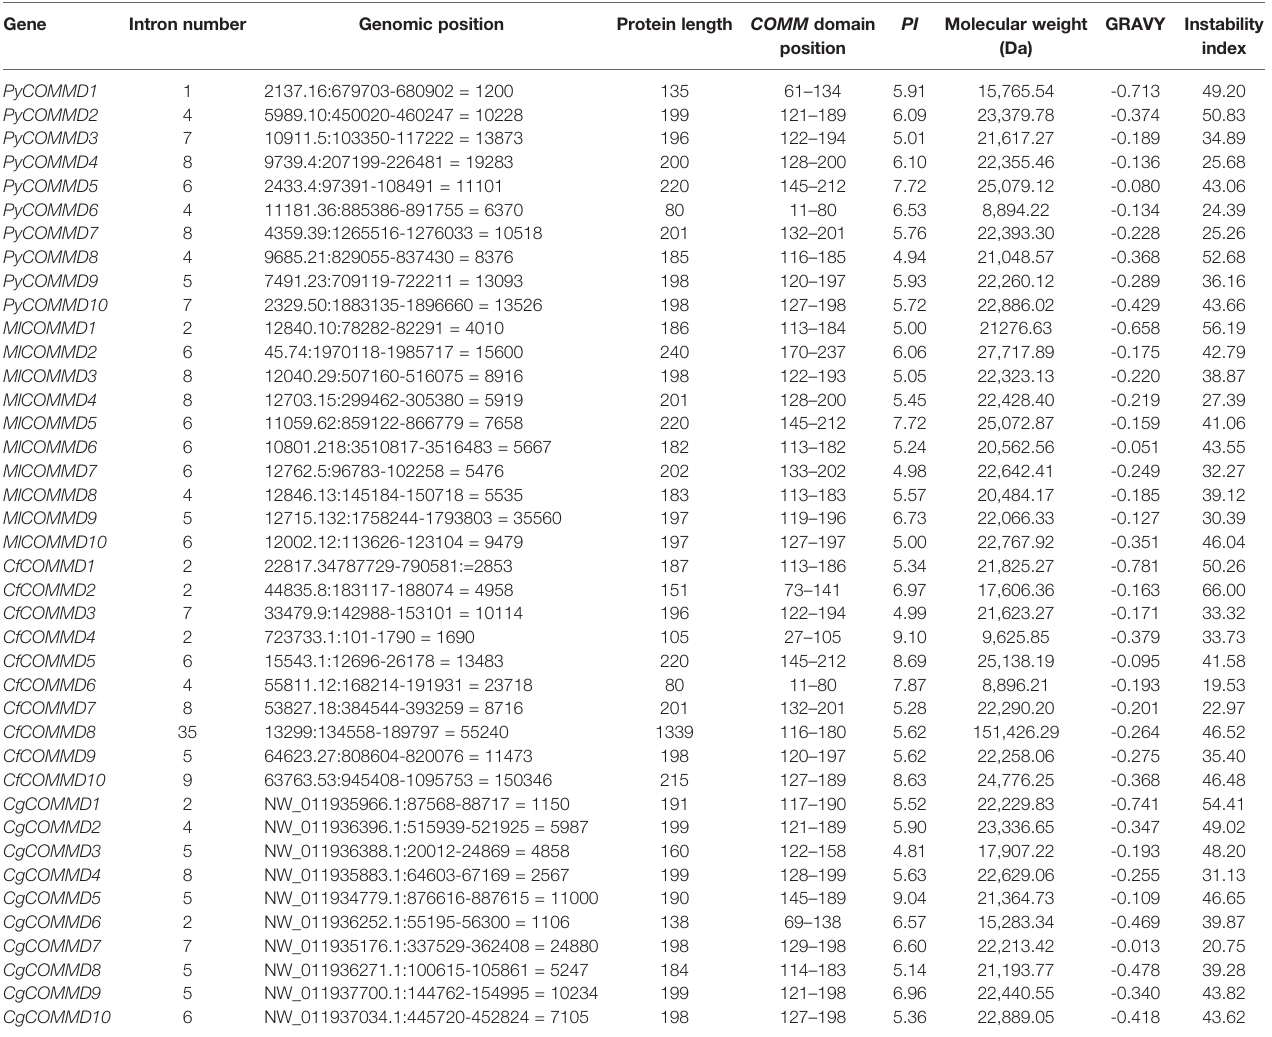
TABLE 1 | Sequence characteristics of the COMMD gene family of four bivalve